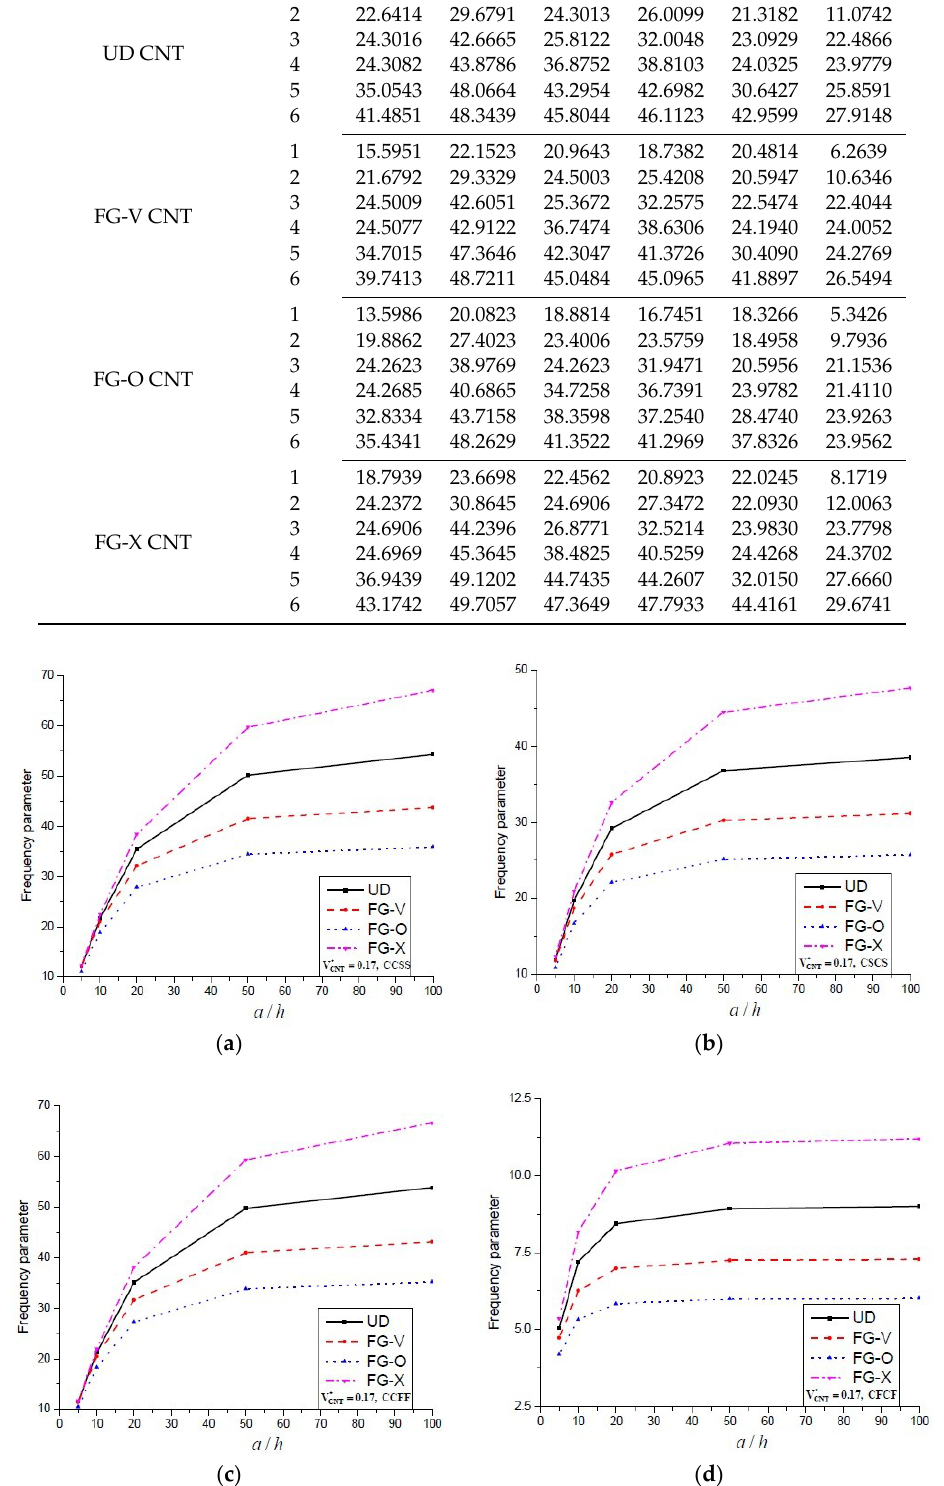
Figure 2. The variation of dimensionless frequency parameter vs. a/h ratio for an FG-CNT-reinforced plate with different types of boundary conditions. ( a ) CCSS; ( b ) CSCS; ( c ) CCFF and ( d ) CFCF.